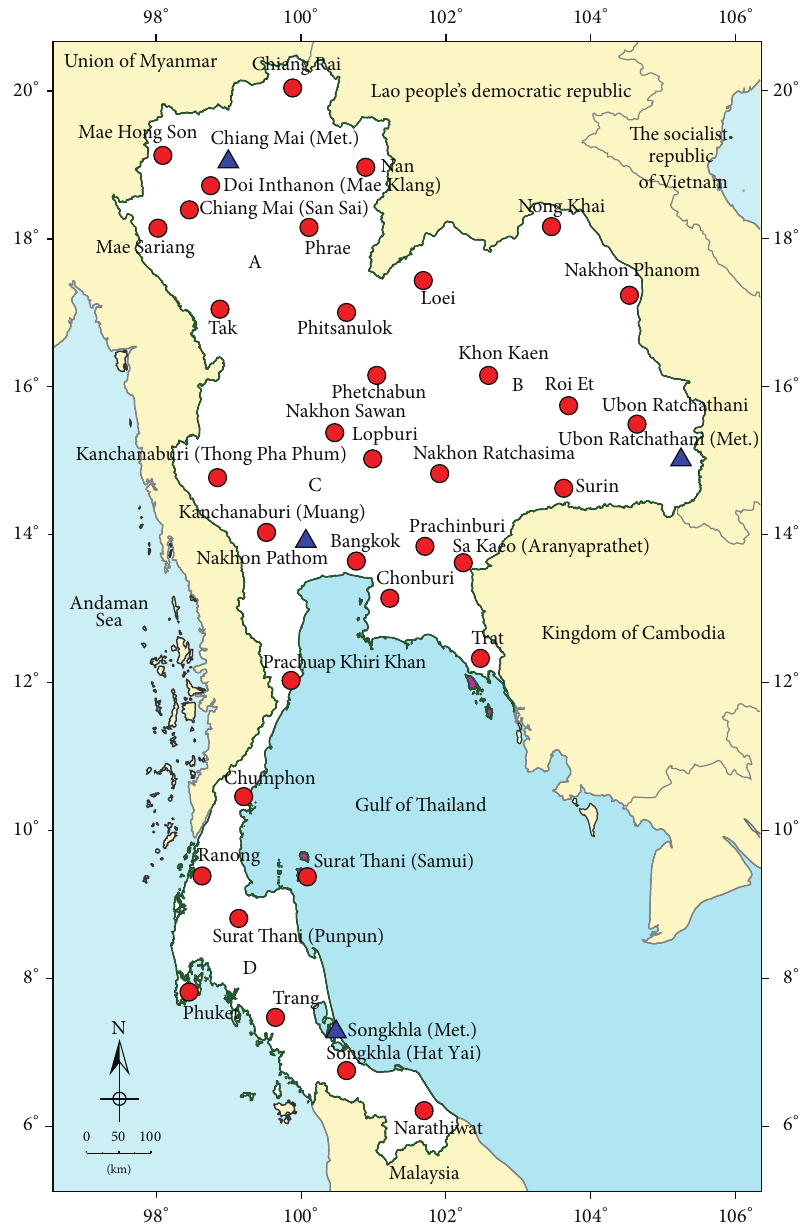
Figure 3: Positions of solar radiation monitoring stations where solar radiation data are used for the model validation (red circle). Positions of the stations where solar radiation data are employed to relate 𝜌 the northern region, northeastern region, central region and the southern